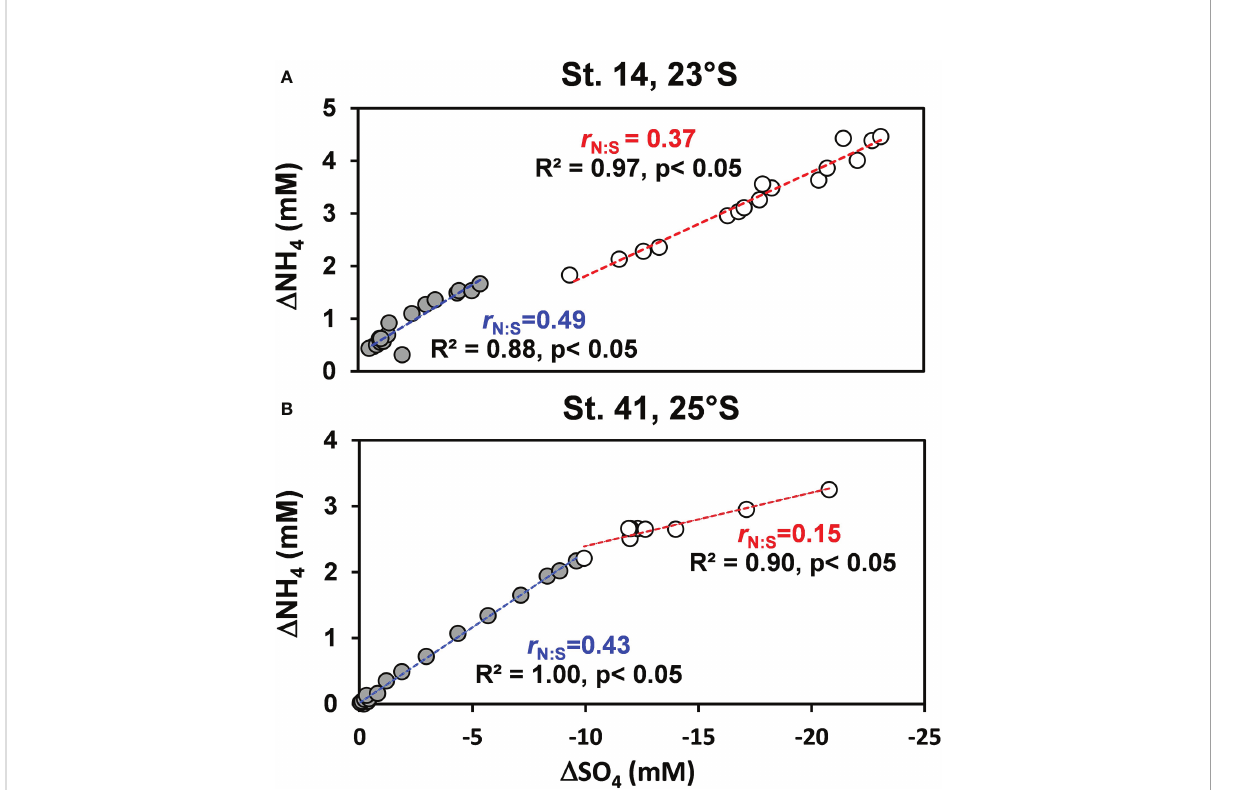
FIGURE 5 NH + 4 − SO 2 − 4 property – property plots for the changes in porewater NH + 4 and SO 2 − 4 concentrations relative to the bottom water concentrations (shown as the capital delta, D ) at (A) St. 14 and (B) St. 41. The slope of the correlation ( d NH + 4 = d SO 2 − 4 ) is used to calculate r N:S (Eq. (5)). The data for each regression were chosen by eye from the conceivable changes in slope. In panel (A) , the fi lled circles represent data from 0.5 to 32 cm, and the open circles below 47 cm. In panel (B) , the fi lled circles represent data from 0.5 to 34 cm, and the open circles below 44